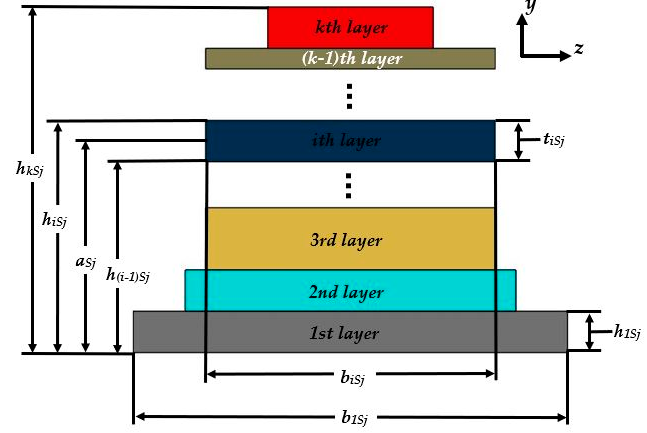
Figure 4. Schematic view of the layers located on the j th section of the piezoelectric